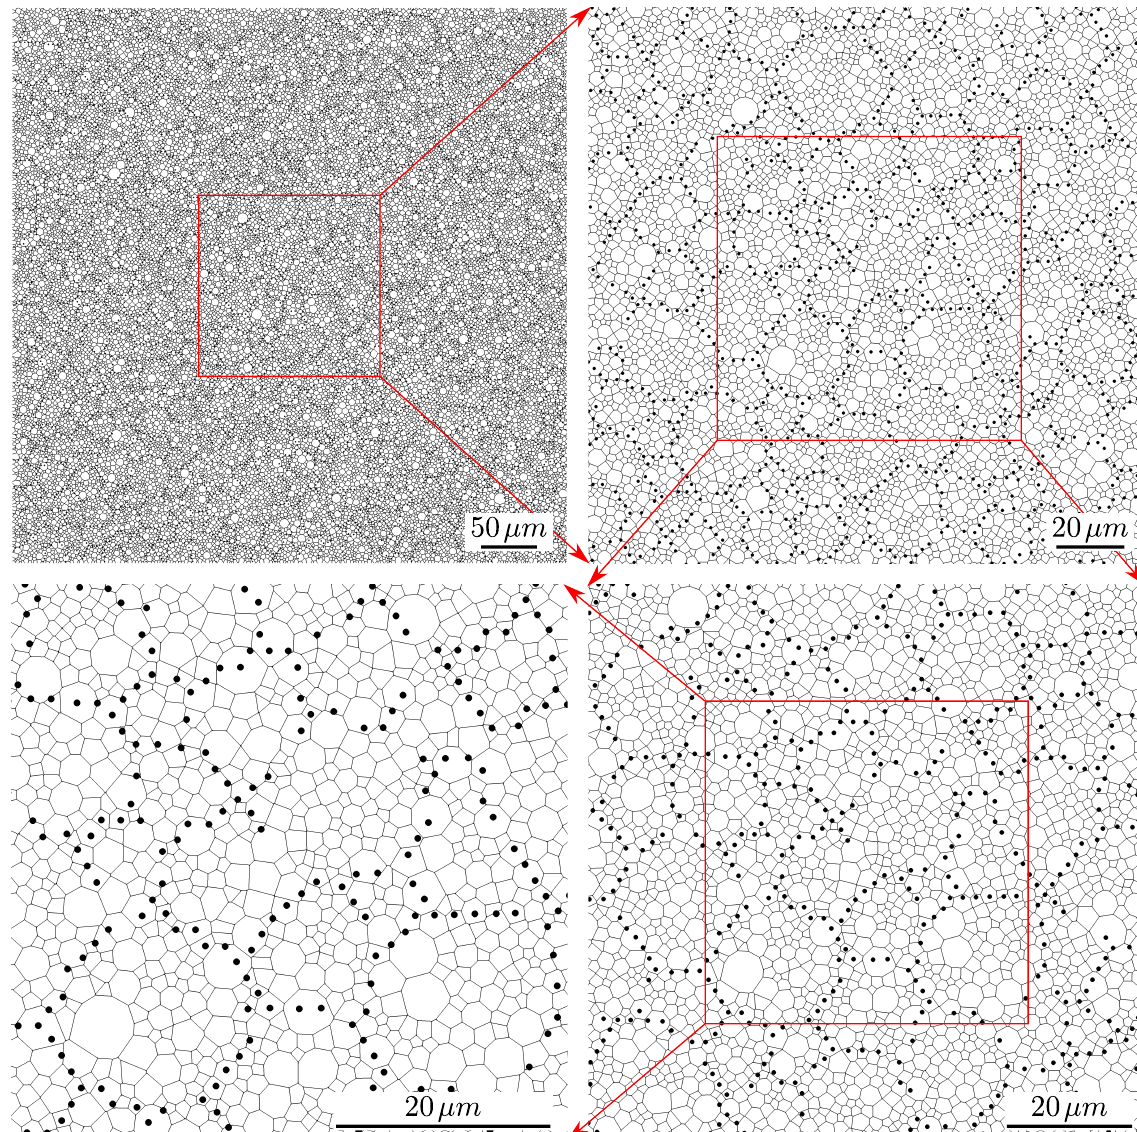
Figure 14. Successive zooms illustrating the initial statistical microstructure used to describe the N 19 superalloy with the black PPB